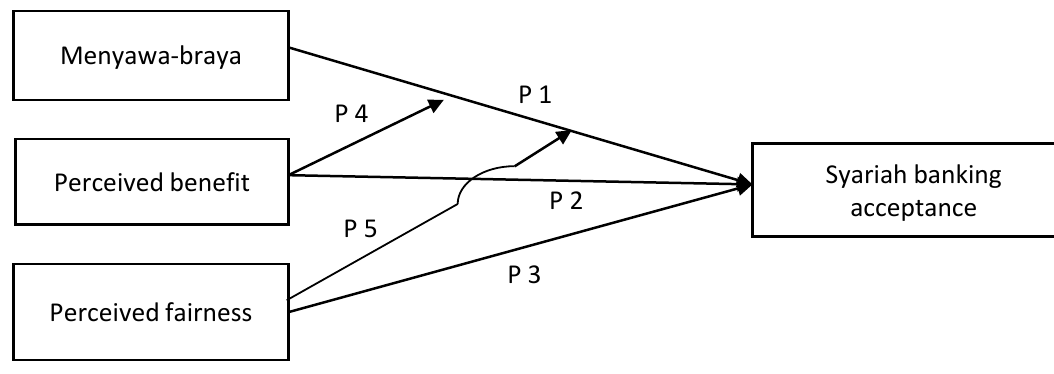
Figure 1. Relationship between